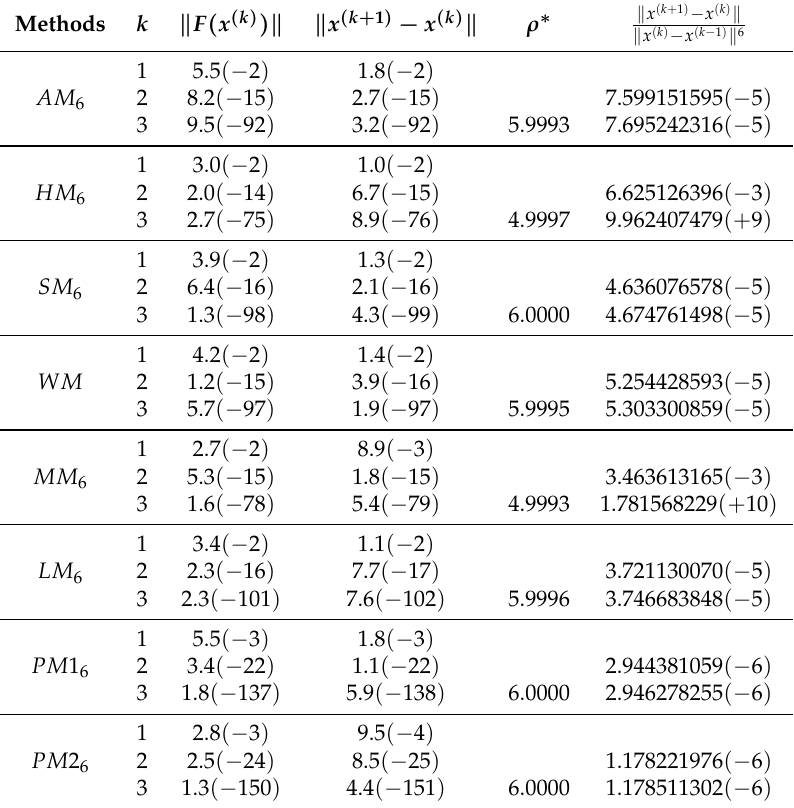
Table 6. Comparisons of different methods on Example 5.